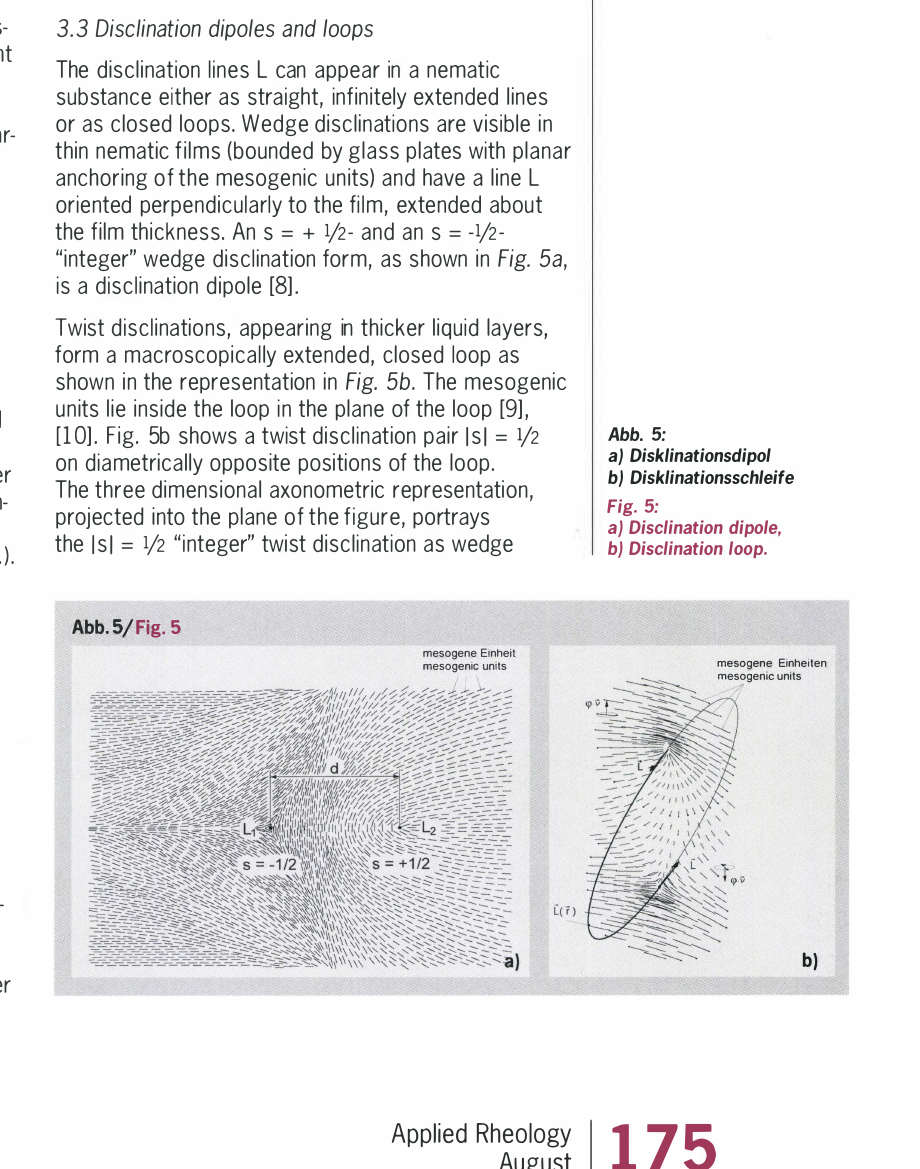
Fig. 4: a} Volterra process for curved twist disclinations, b) Configuration of mesogenic units at the Burgers circuit around the line L for a planar s = + ljz "integer" twist disclination.